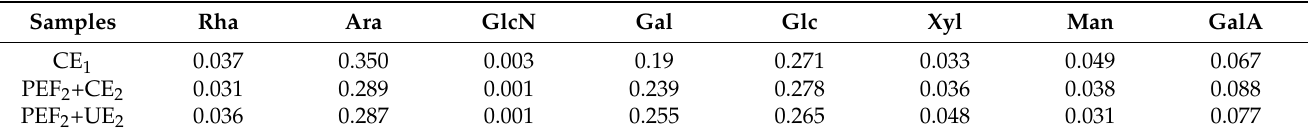
Table 2. Monosaccharide compositions of Se − TPSs (molar ratio).